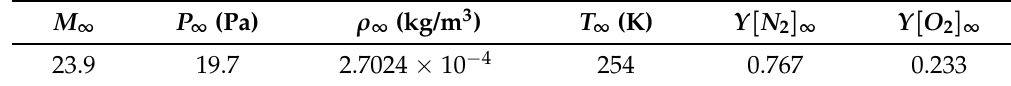
Table 5. RAM-C free-stream conditions.